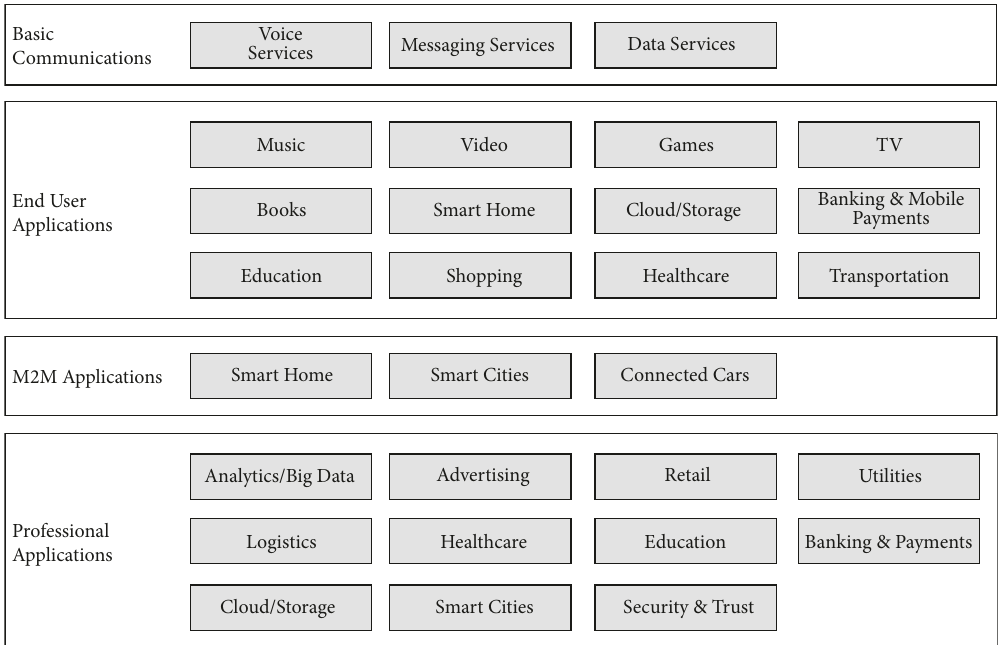
Figure 1: Telecom value chain